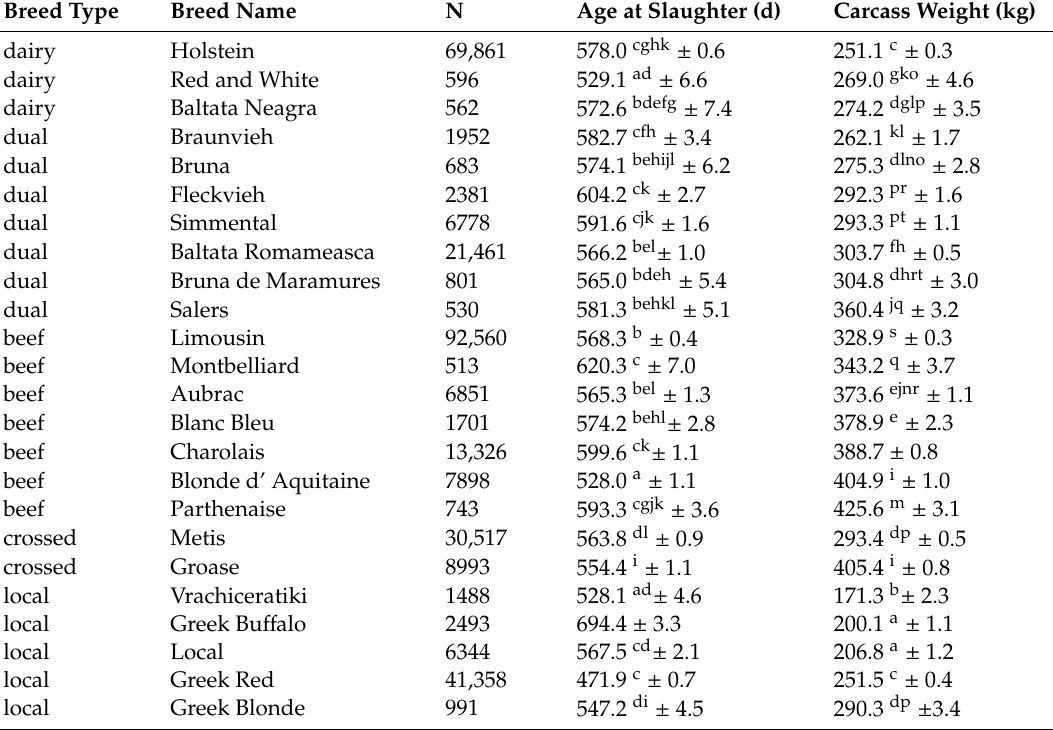
Table 1. Number of carcasses per breed (N), means ± std. error for the age at slaughter (days, d) and the carcass weight (kg) from 24 cattle breeds ( > 100 observations) reared in